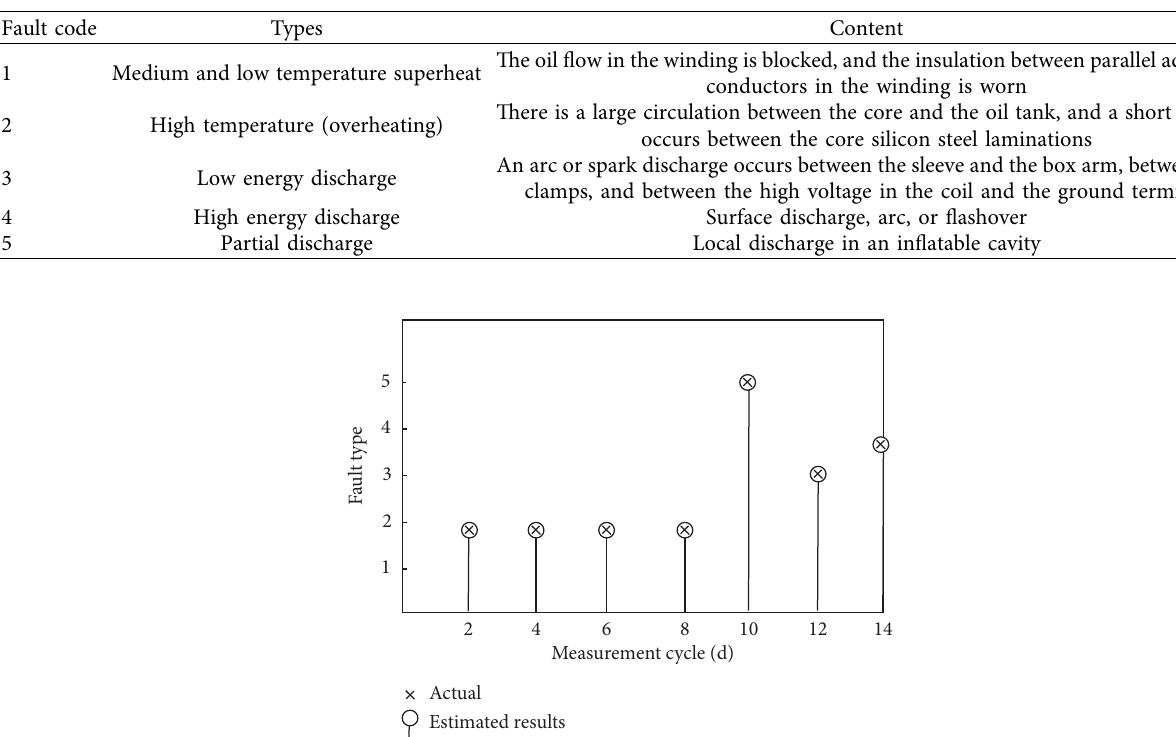
Table 1: Abnormal problems of the power system.